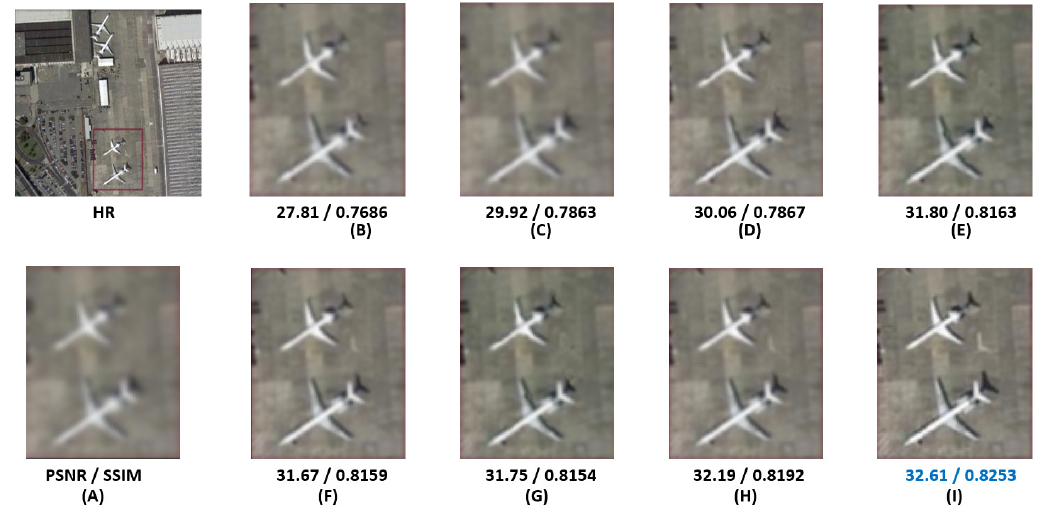
Figure 16. Comparison of values with different algorithms on the 3× “P0808” airport picture: ( A ) LR; ( B ) bicubic; ( C ) SRCNN; ( D ) FSRCNN; ( E ) VDSR; ( F ) EDSR; ( G ) LapSRN; ( H ) SRGAN; ( I ) ours.